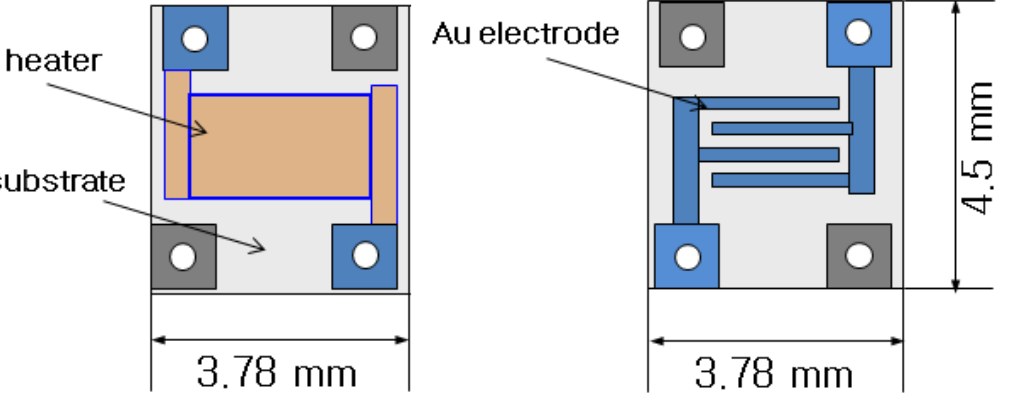
Figure 1. Structures of the fabricated sensor’s substrate.